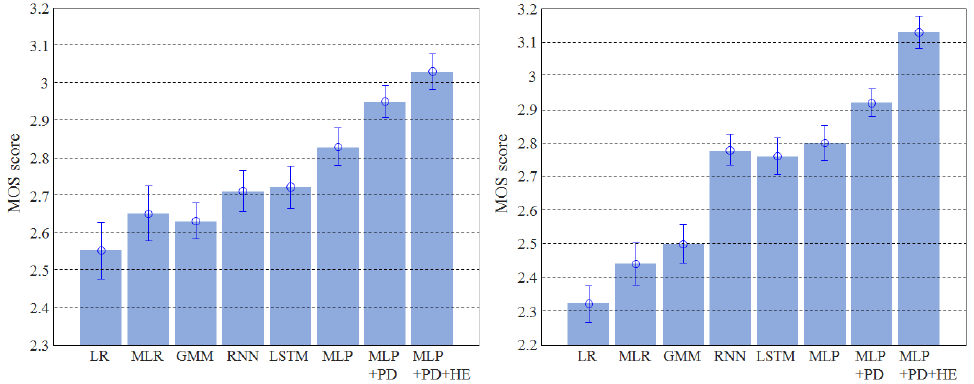
Figure 8. Average MOS scores with error bars for each method. ( Left ): Intelligibility. ( Right ):